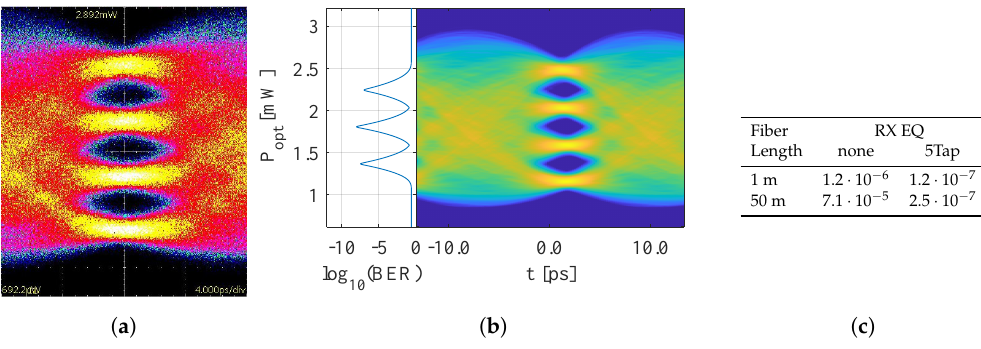
Figure 12. 112 Gbit/s eye diagrams using ( a ) no RX EQ and ( b ) 5 RX taps, ( c ) BER using different lengths of